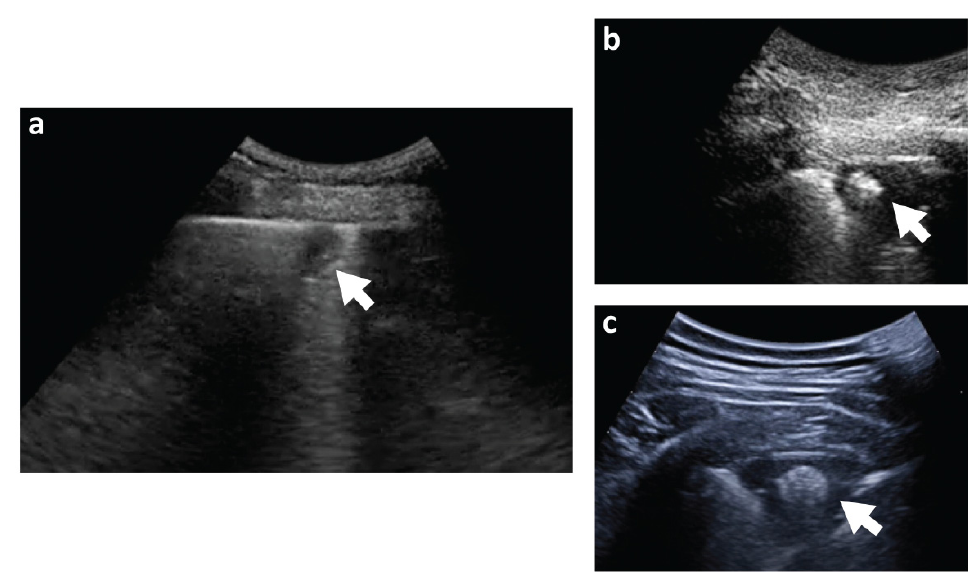
Figure 2. ( a ) Small (11 × 9 mm) subpleural consolidation detected at lung echography. Clear pleural discontinuity with the underlying hypoechoic area. ( b , c ) Typical ultrasound appearance of “bubbly consolidation” with a roundish hyperechoic area in the context. Arrows indicate the consolidation at lung echography.